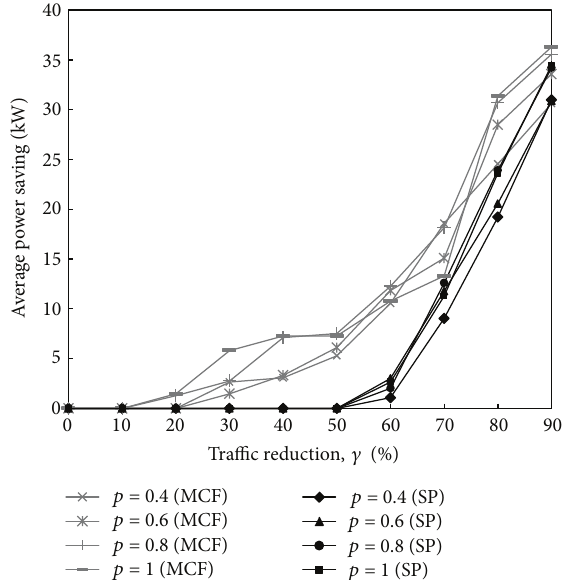
Figure 6: Power consumption saving obtained using MEE Heuristic with MCF and Dijkstra rerouting approach and in the case of the Network